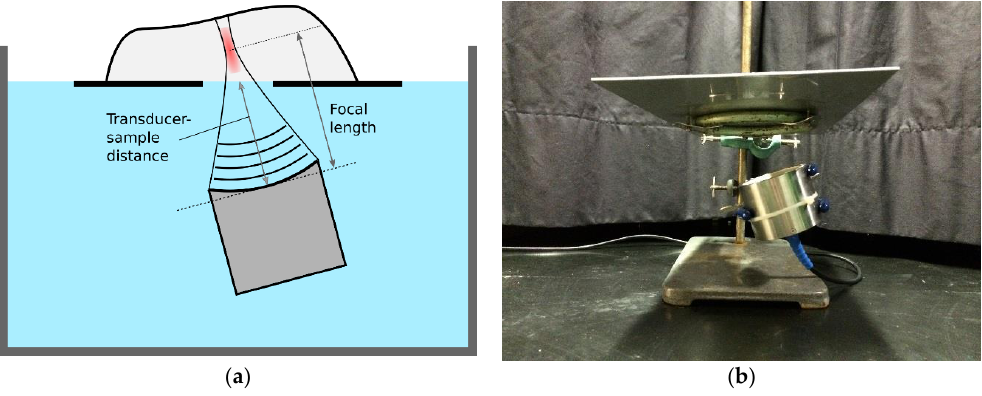
Figure 2. HIFU setup with a transducer and plate to hold the fillet. ( a ) Schematic illustration with a transducer placed in a water bath; ( b ) Image showing a transducer and plate mounted to a metal stand.